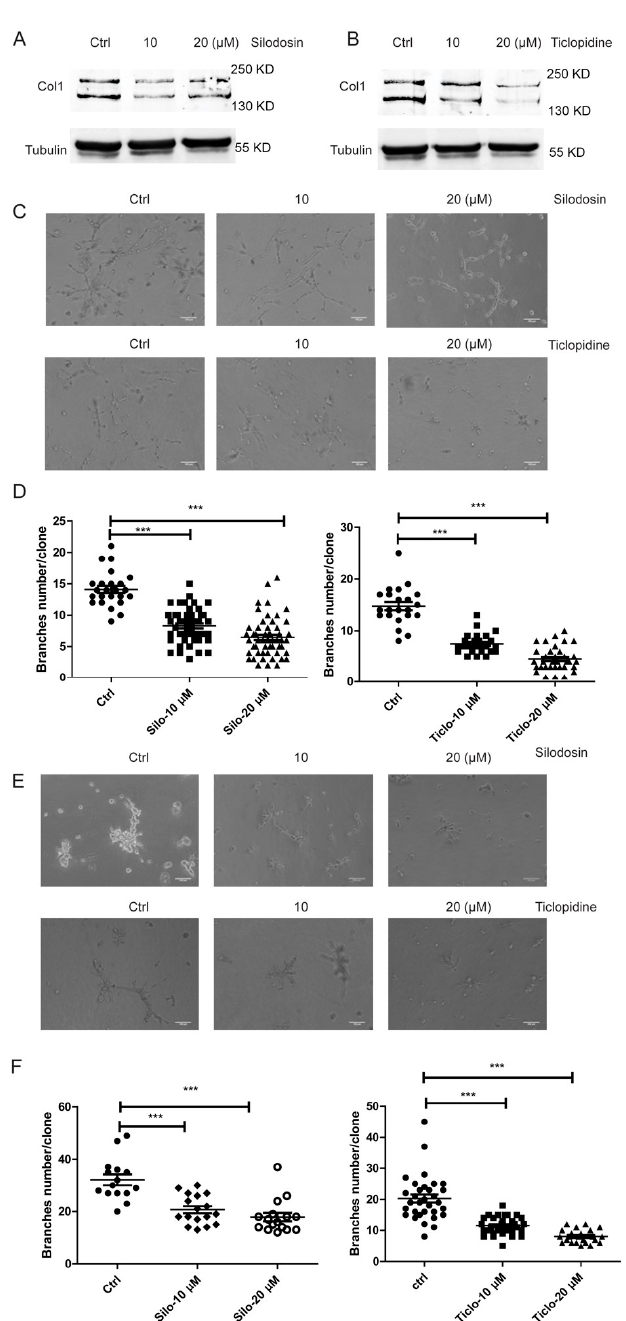
Figure 5. Silodocin and ticlopidine inhibit collagen deposition and cancer cell invasion. ( A ) Western blot analyzed levels of type I collagen in conditional medium of HS578 cells, The cells were treated with Silodosin at 10 µ M and 20 µ M. ( B ) Western blot analyzed levels of type I collagen in conditional medium of HS578 cells, The cells were treated with Ticlopidine at 10 µ M and 20 µ M. ( C ) Invasiveness of MDA-MB-231 cells was examined in 3D culture assay in the presence or absence of Silodosin and Ticlopidine. The cells were with Silodosin or Ticlopidine at 10 µ M and 20 µ M, and images were taken after 48 h. Scale bar, 100 µ m. ( D ) Dot blot graph quantified invasive branching structures in panel C. One-way ANOVA analysis; n ≥ 20. *** p ≤ 0.001. ( E ) Phase images of control and Hs-578 cells treated with Silodosin and Ticlopidine at 10 µ M and 20 µ M in 3D culture assay. Images were taken at 24 h after treatment. Scale bar, 100 µ m. ( F ) Dot blot graph quantified invasive branching structures in panel E. One-way ANOVA analysis; n ≥ 20. *** p ≤